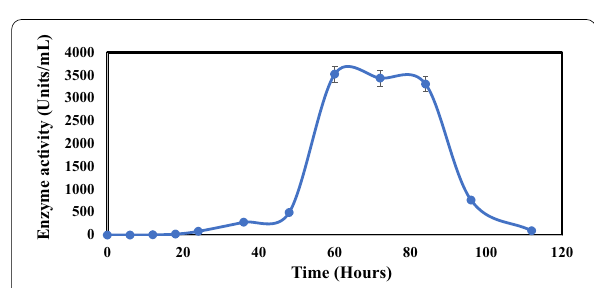
Fig. 2 Time course profile of S. marcescens AD-W2 for serratiopeptidase